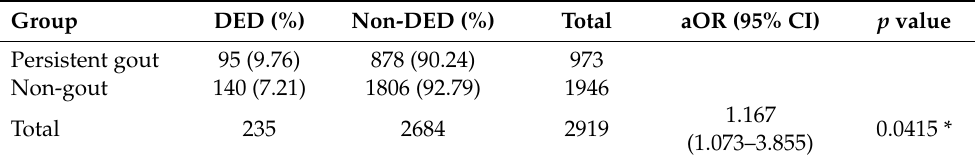
Table 2. Incidence of dry eye in the persistent-gout and non-gout groups. Group DED (%) Non-DED (%) Total aOR (95% CI) p value Persistent gout 95 (9.76) 878 (90.24) 973 Non-gout 140 (7.21) 1806 (92.79) 1946 Total 235 2684 2919